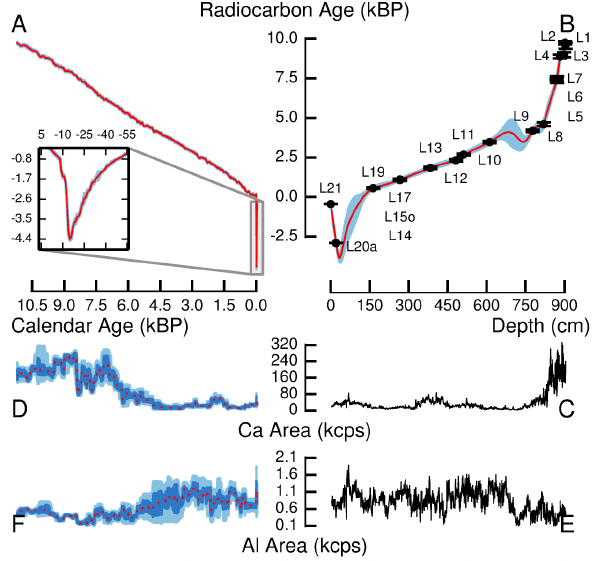
Fig. 7. Comparison of results with OxCal. The proxy records es- timated by the present approach (red, dotted) compared to proxy records obtained by using an OxCal P-sequence age model (dark gray) for the groundwater inflow (Ca area, A ) and surface erosion (Al area, B ) proxies from Lonar lake. Legend for the confidence bounds to the Bayesian proxy estimate is same as in Fig.6, panels D and F . (Color online.)